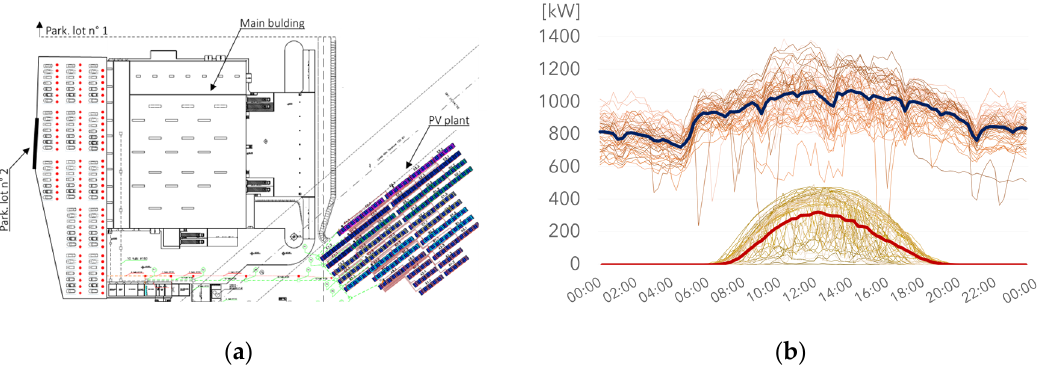
Figure 8. Reference scenario: ( a ) the layout of the building, parking area, and the PV plant. The red marker refers to an EV parking place; ( b ) the daily power flows of the electrical load ( brown ) and the PV plant ( yellow ), and their annual average ( dark blue and red , respectively).